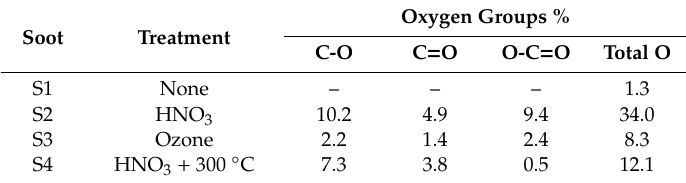
Table 2. Oxygen group percentages for samples